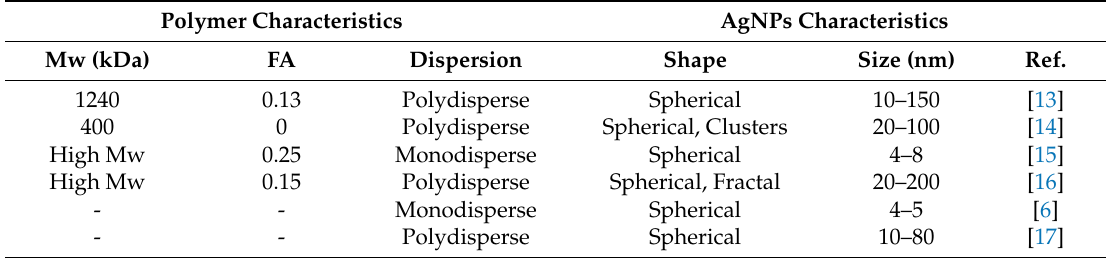
Mw: Molecular weight; FA: Fraction of acetylated